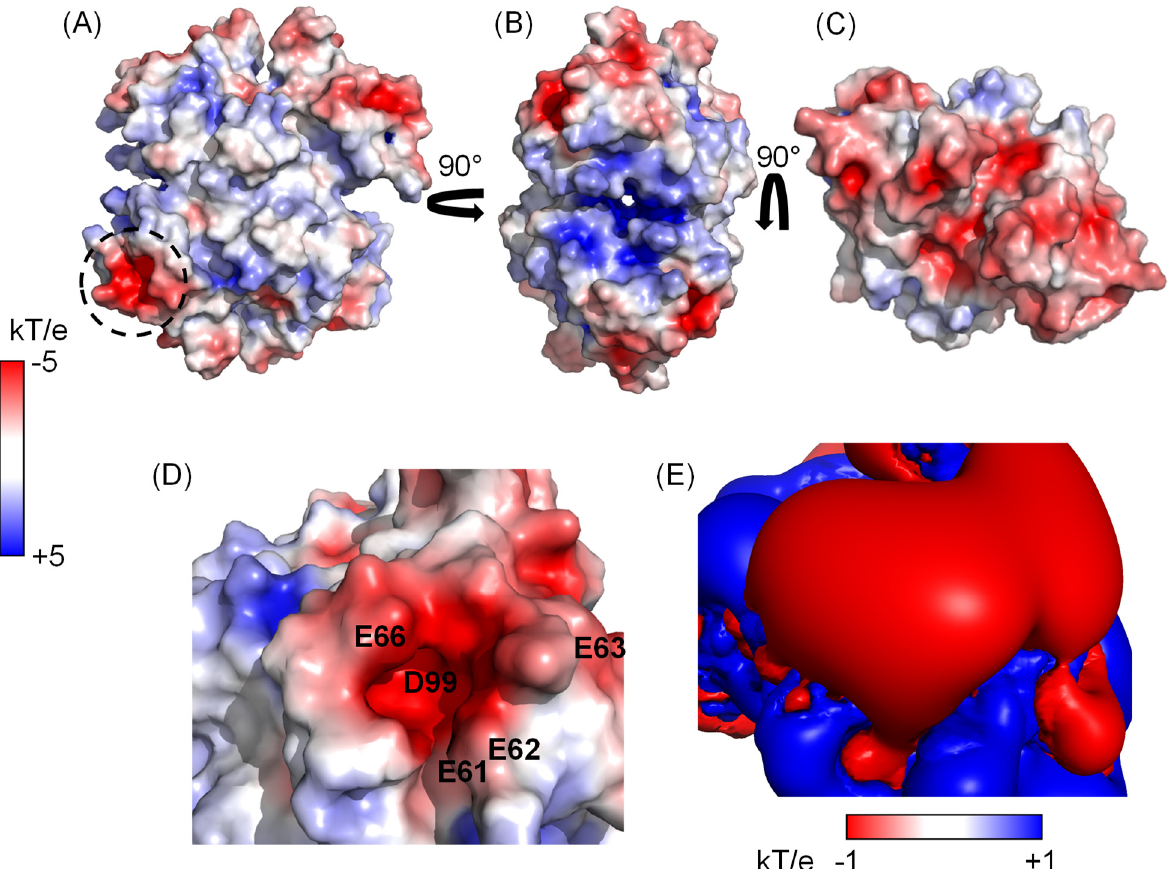
Figure 1. Electrostatic potential mapped on the surface of TTR (pdb: 1tta). In ( A – C ), the whole tetrameric structure with different orientations is depicted, while in ( D ) the highly negatively charged cavity formed by E61, E62, E63, E66 and D99 is zoomed into and the corresponding ± 1 kT/e isopotential electrostatic field is represented in ( E ). The dashed circle in panel ( A ) corresponds to the zoomed in region of panels ( D , E ). All the calculations were performed using APBS [18] in Pymol.